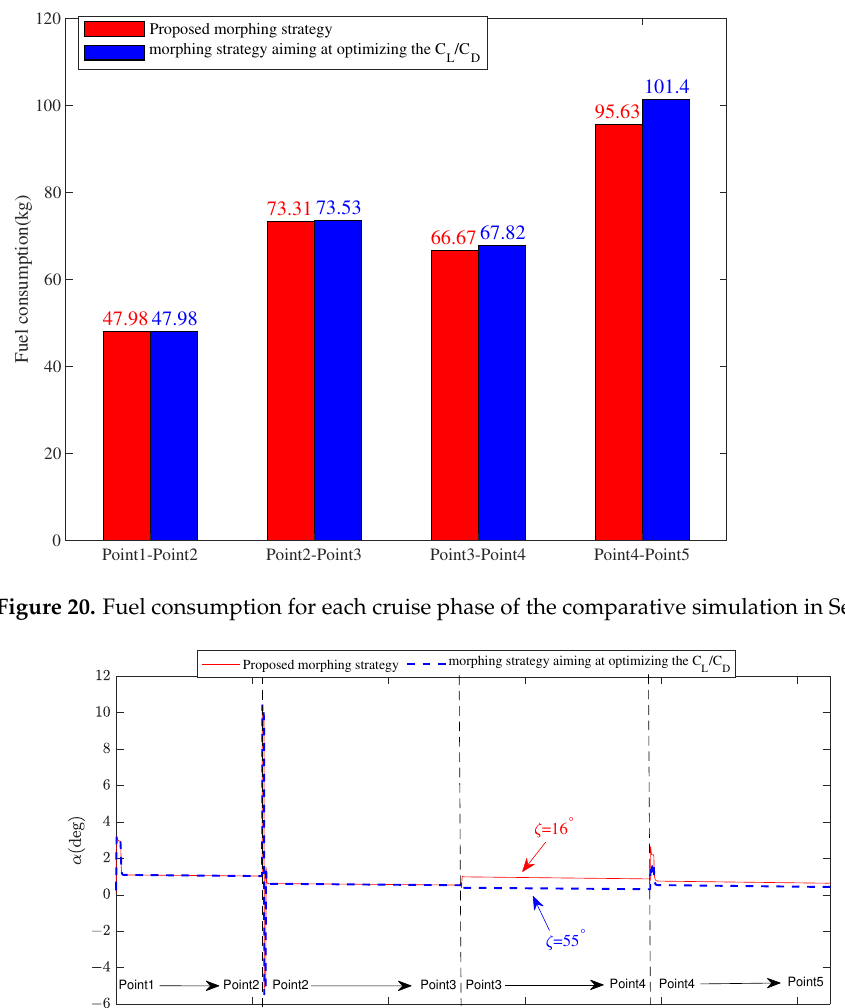
Figure 19. Engine thrust and fuel consumption of the comparative simulation in Section 5.2.